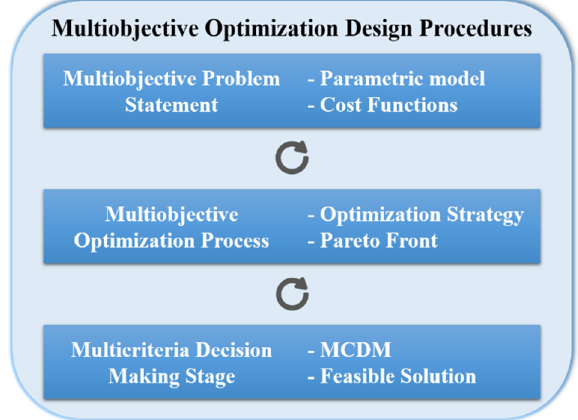
Figure 8. Multiobjective optimization procedures for control systems (adapted from [44]).